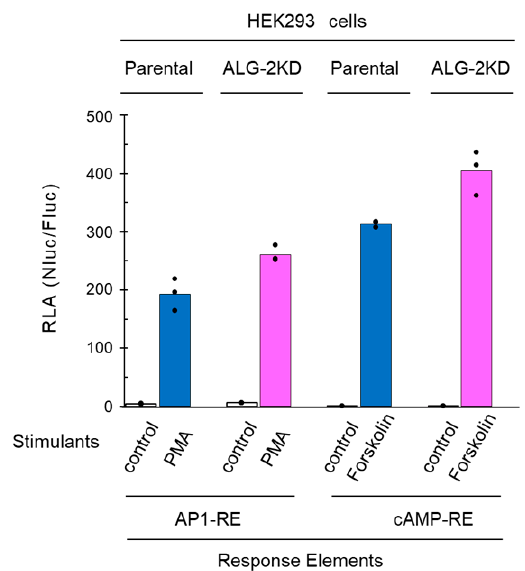
Figure 5. Comparison of reporter activities of AP-1 response element (AP1-RE) and cyclic AMP